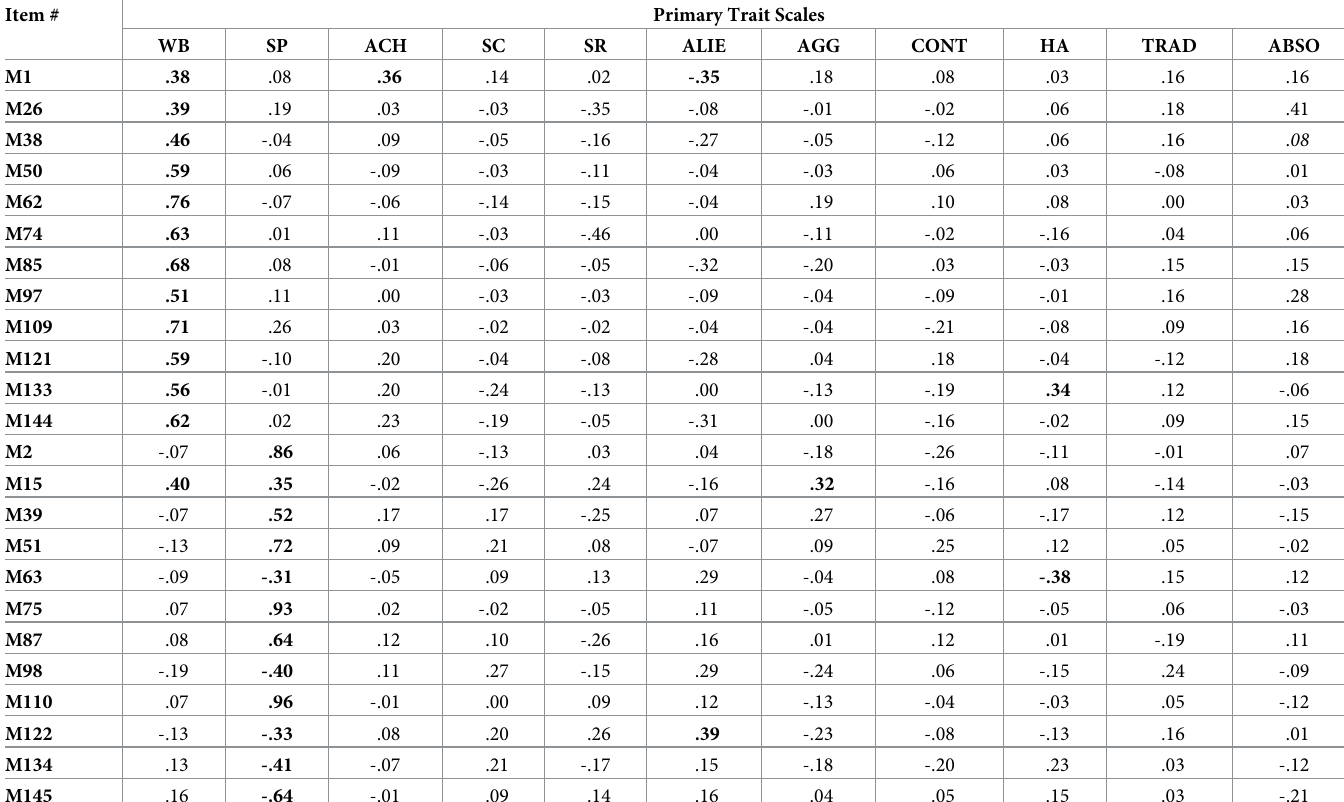
Table 2. Factor loadings for the MPQ-BF items in the ESEM model with 11 primary trait